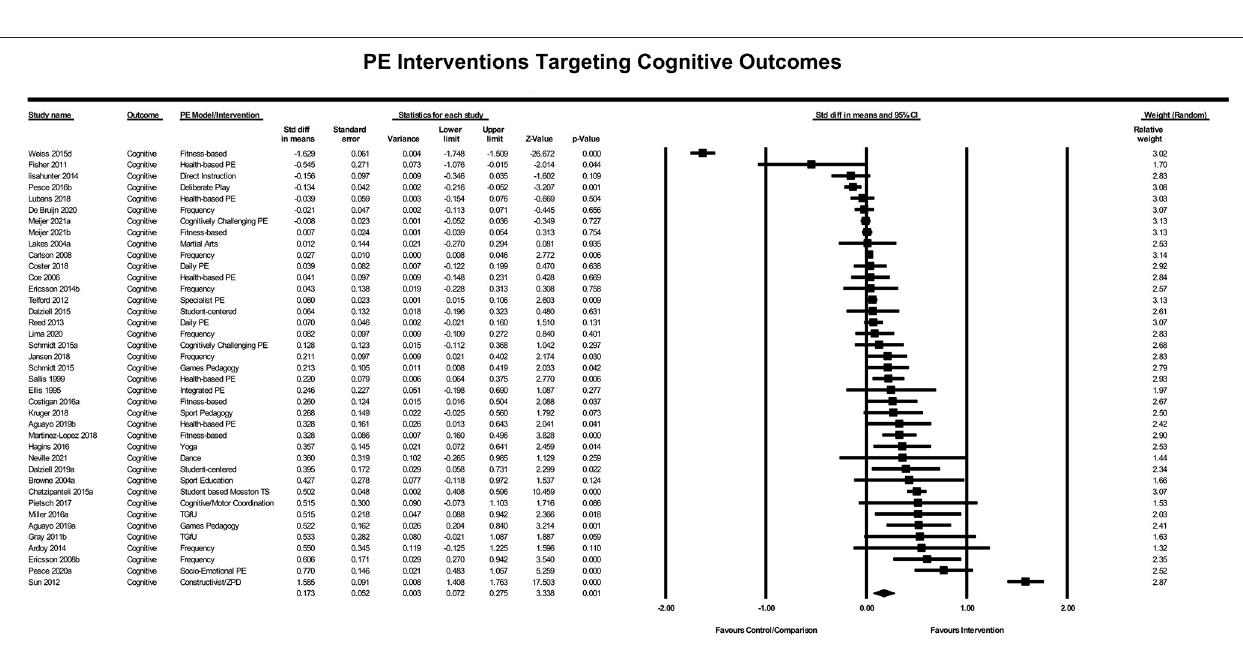
FIGURE 2 | Funnel plot of standard error by standardized difference in mean of combined learning effects.